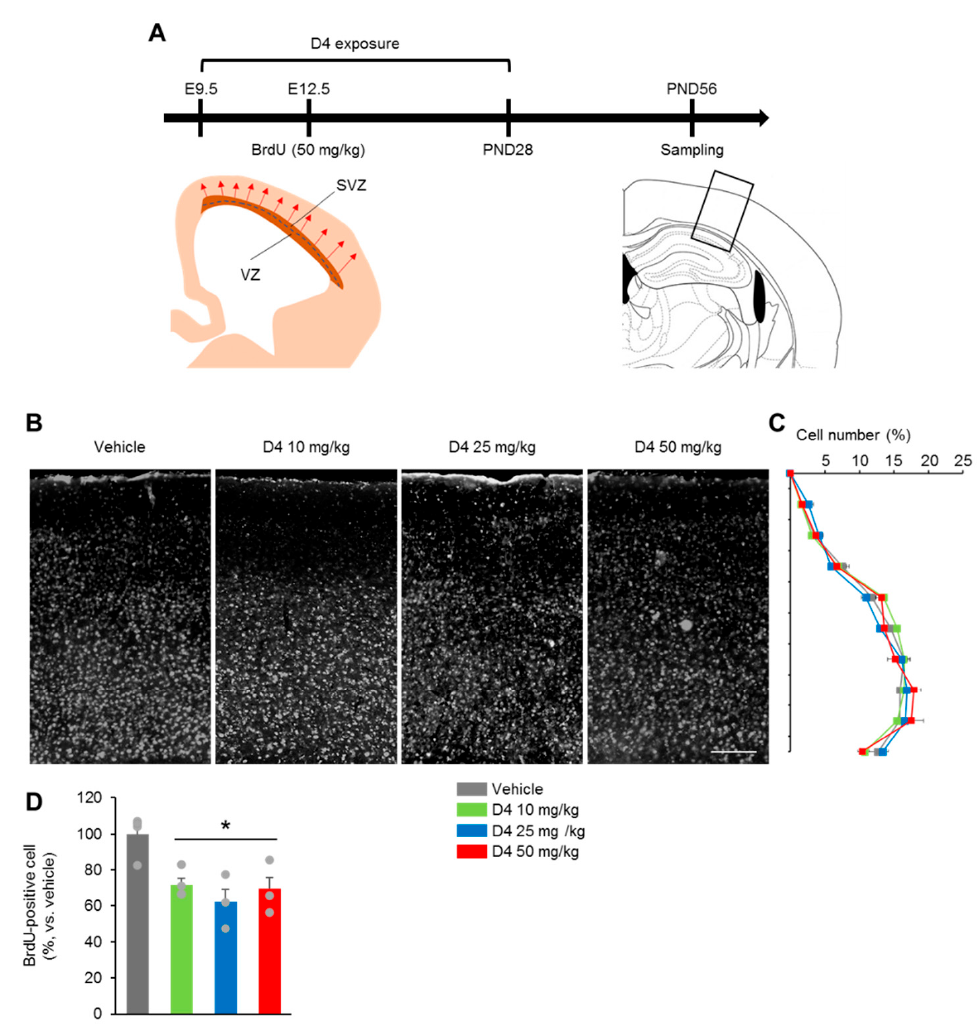
Figure 5. Prenatal D4 impaired neurogenesis but not the neural migration. ( A ) The pregnant mice received a single BrdU injection on E12.5, 3 h after the D4 administration to label mitotic progenitors in the embryonic brains. The brains of adult offspring mice were collected to examine cell migration. ( B ) The percentage of BrdU + cells at each distance from the apical side is shown. There was no difference in the distribution of BrdU + cells in the cerebral cortex (F 3,22 = 1.406, p = 0.2718). ( C ) The numbers of BrdU + cells in the tangential direction were shown. ( D ) The numbers of BrdU + were lower in the D4-treated groups than in vehicle group (F 3,22 = 6.855, p = 0.086). n = 5–6 per group. Data represent mean ± SEM. Statistical significance was determined by one-way ANOVA with Bonferroni correction. * p < 0.05 vs. vehicle. Scale bars: 200 µ m in ( B ).